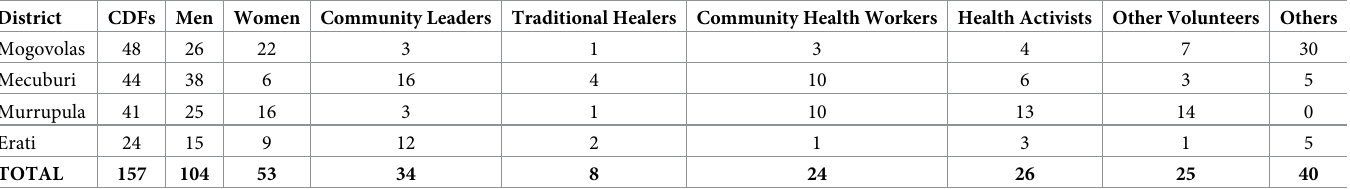
Table 4. CDFs by district, gender and position in their community. District